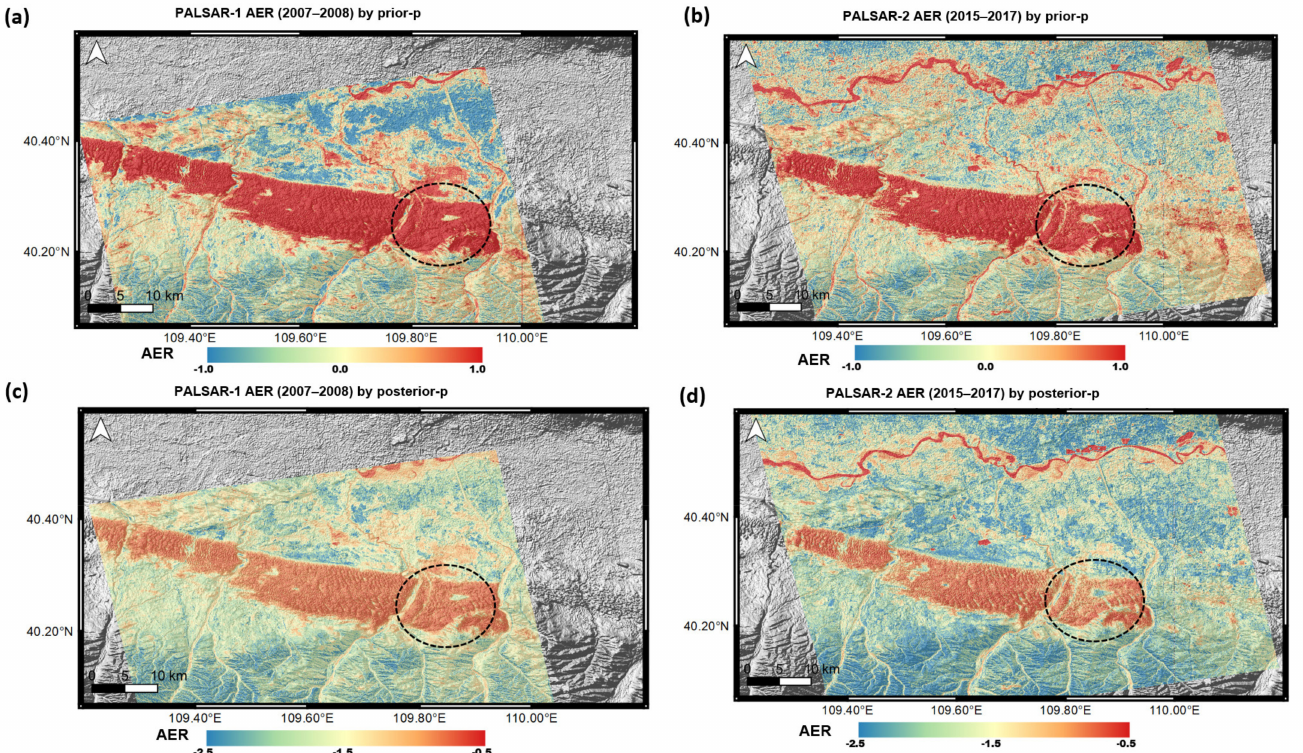
Figure 7. AER maps using ALOS PALSAR-1/2 during 2007–2008 and 2015–2017 periods using a prior processor in ( a , b ) and a posterior processor in ( c , d ). Noted that the effects of combating desertification activities are obvious in the posterior processor